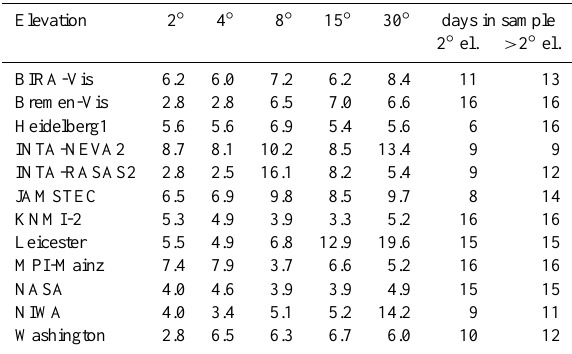
Table 3. Standard deviation of slopes of daily straight-line fits of visible MAX-DOAS NO 2 data to the visible reference data set, over the whole campaign, in units of % of 1.00, together with the number of days in the